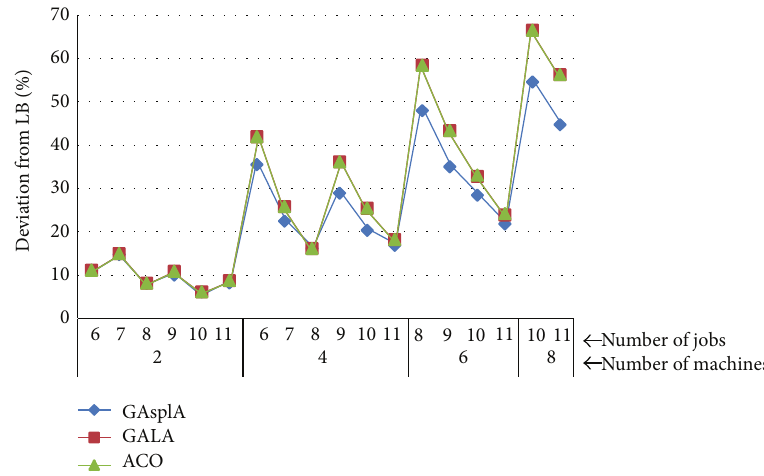
Figure 13: Deviation of each algorithm from the LB-small instances.